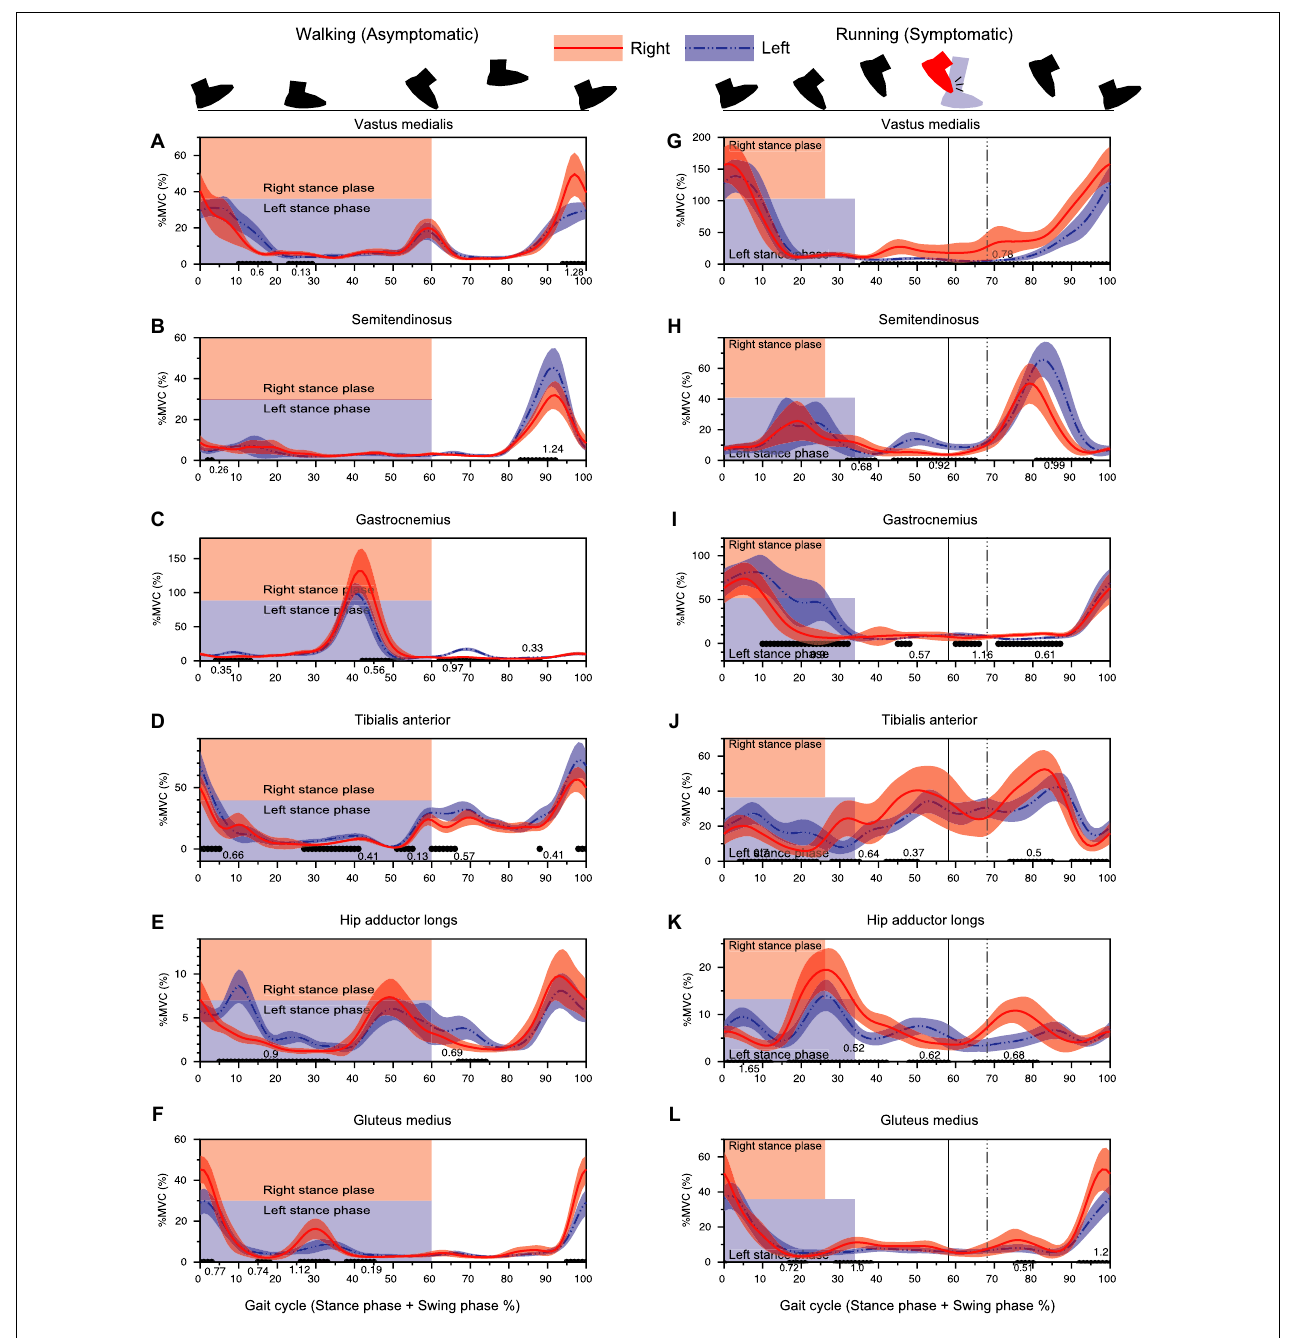
FIGURE 6 | Results of EMG analysis during walking (left column) and running (right column) assessed by 1D-SPM. The black lines with the Cohen’s d -value at the horizontal axis of each panel showed significant differences between the right and left legs. Vertical lines denote the timing of foot collision for right leg (solid line) and for left leg (dashed line). Note that the percentage of the stance-phase and the foot collision time was different between the right and left legs in 100% gait cycle representation since the absolute stance-phase duration was significantly different between limbs ( Figure 3 ).